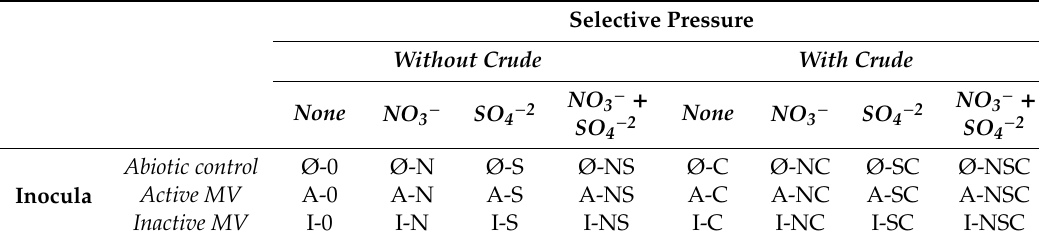
Table 5. Identification of selective cultures of deep-sea mud volcano sediments amended with di ff erent electron acceptors (in italics). Whenever sub-sample identification is required the letters a, b and c are used for the di ff erent